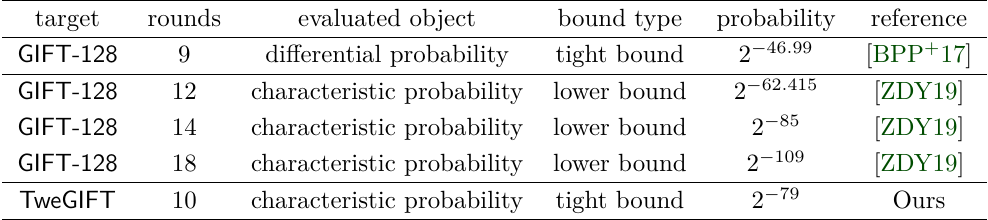
Table 3: Comparison of the Guaranteed Differential Property for GIFT-128 and TweGIFT via Non-Zero